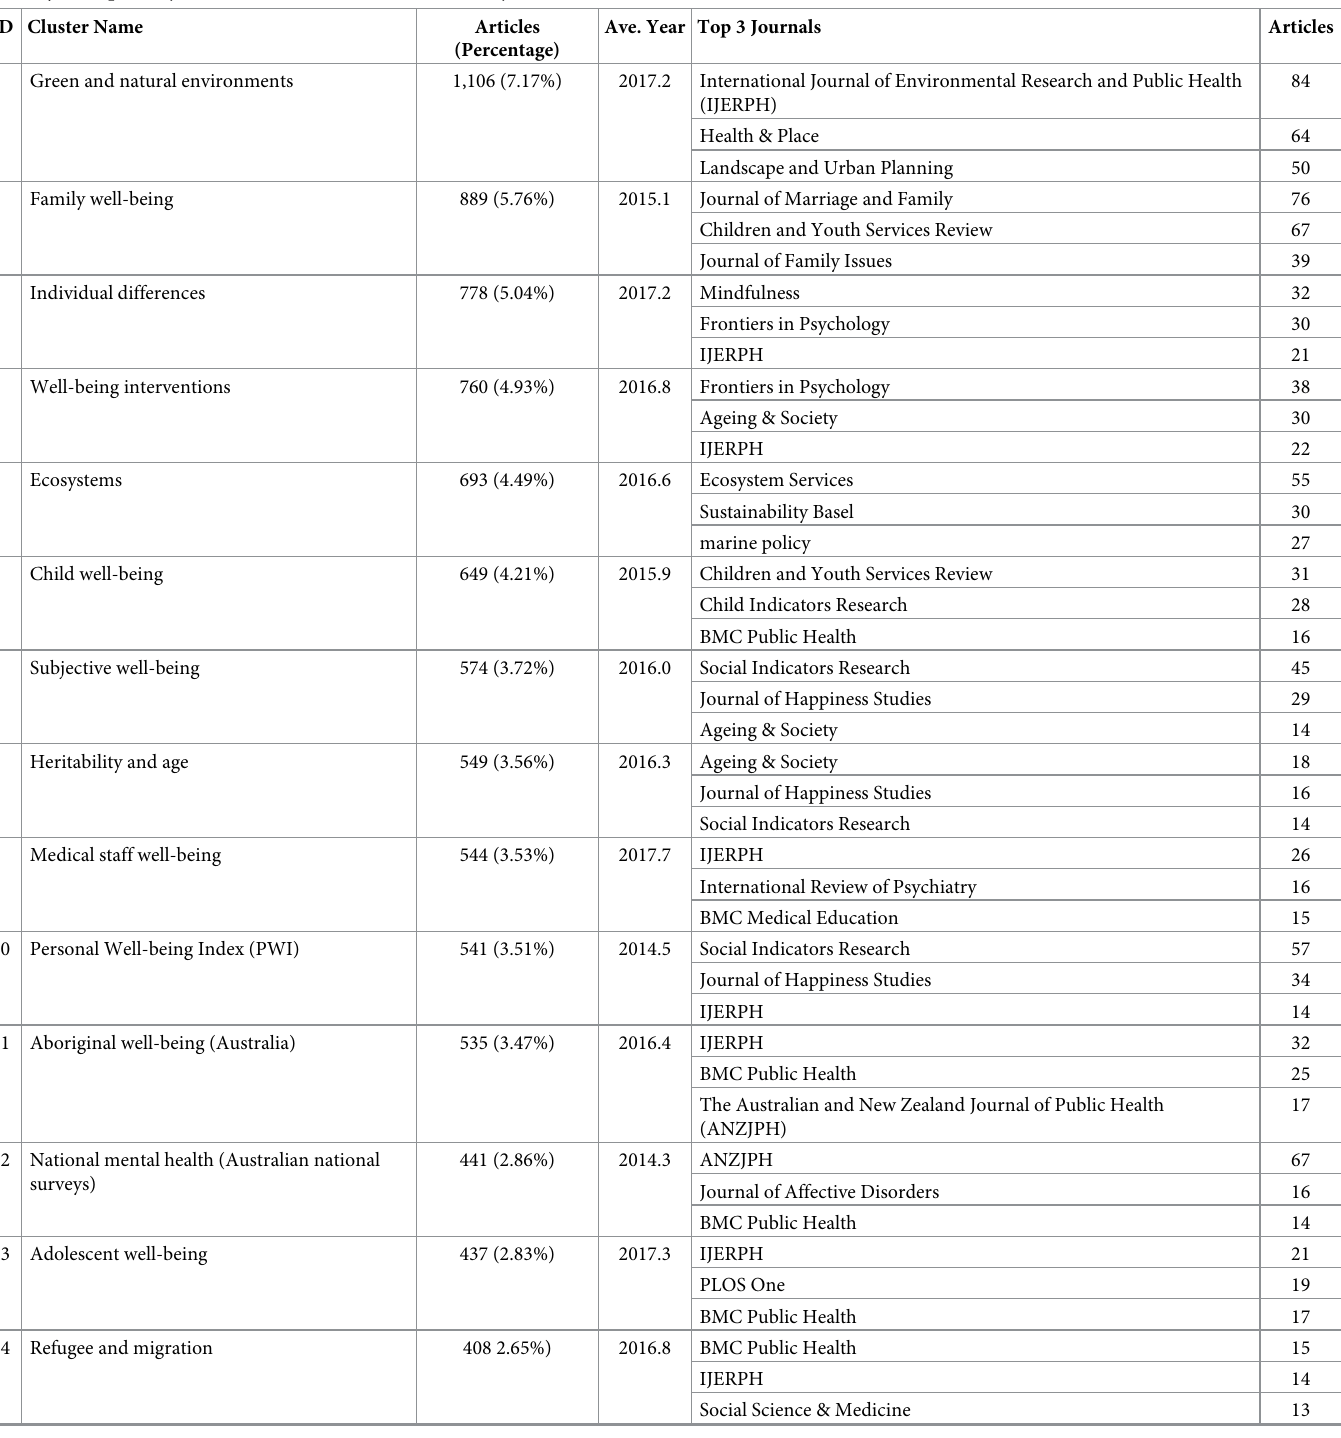
Table 2. The top 24 clusters of well-being research named using the dominant theme with the most important quantitative data (number of articles, average publi- cation year, top three journals, and number of articles in each journal) until